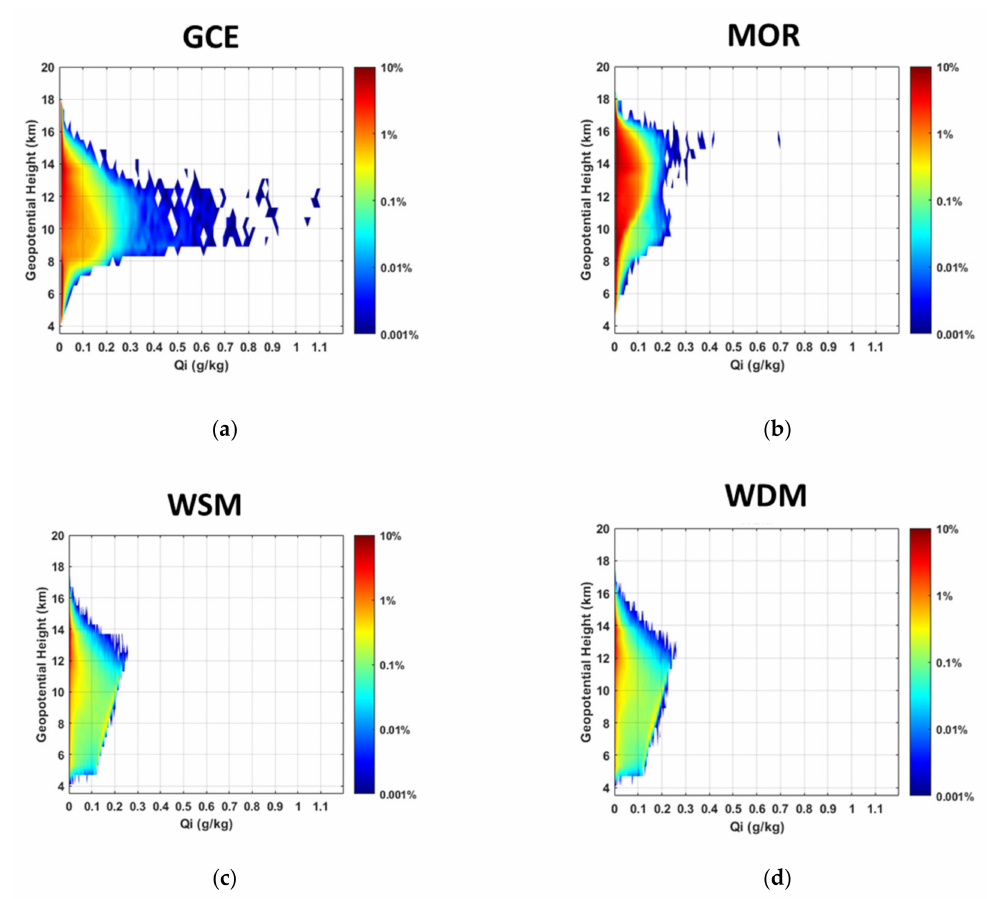
Figure 11. Probability distributions of Qi simulated with ( a ) GCE, ( b ) MOR, ( c ) WSM, and ( d ) WDM. The shaded color displays the probability at each altitude. The simulation is initial at 060112 UTC and valid at 06021200